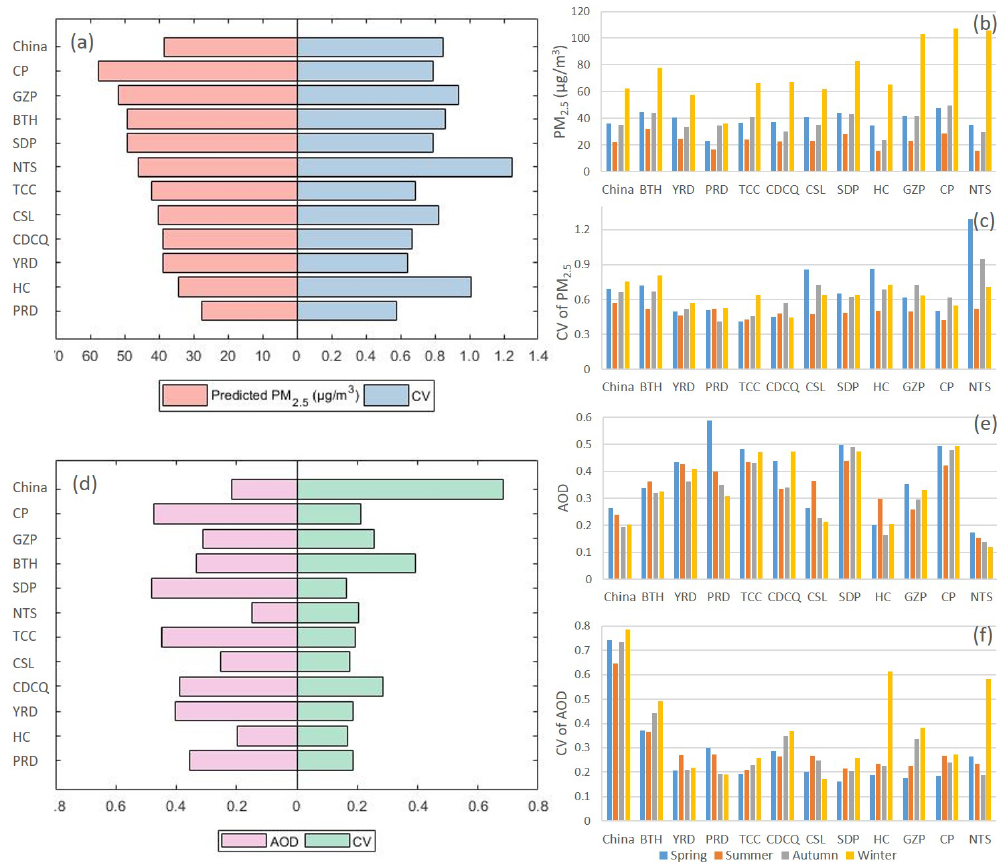
Figure 3. Regional mean values and coefficient of variation (CV) values for PM 2 . 5 and AOD in 2019. Panel (a) shows the mean PM 2 . 5 and its CV for 11 urban agglomerations for the whole study period, and panels (b) and (c) show the mean PM 2 . 5 and the CV values for each respective season. Panel (d) shows the mean AOD and its CV in regions for the whole year, and panels (e) and (f) show the mean AOD and the CV values in each respective